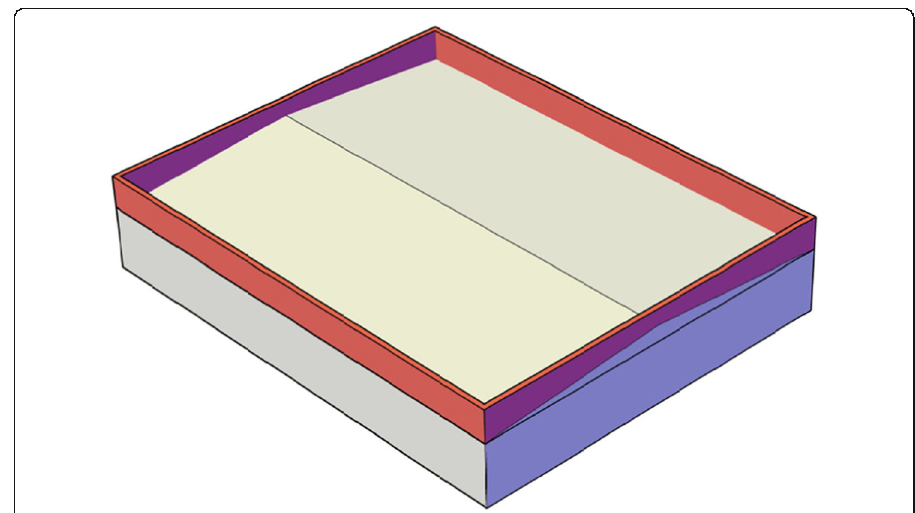
Fig. 3 The solid parapet on the roof of the low-rise building model